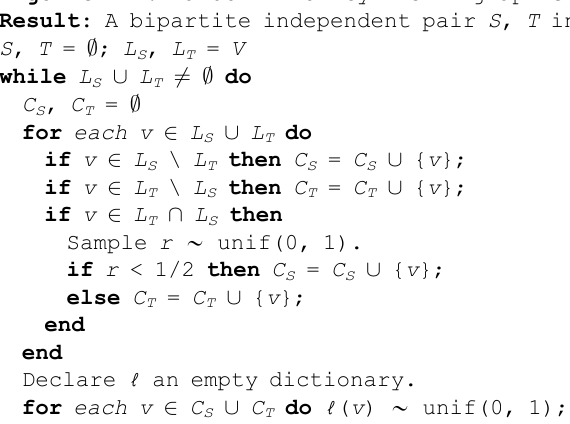
Algorithm 4 : Random Priority BIS in graph G = ( V , E ) (Blue Step